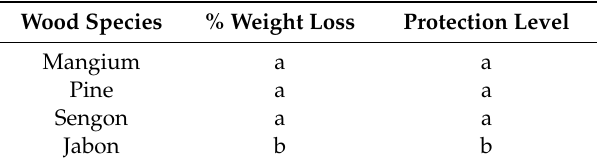
Table 4. Duncan’s multi-range test of percent weight loss and protection level on wood species. (The same letters in each column are not statistically different ( p ≤ 0.05) according to Duncan’s multiple range test.)